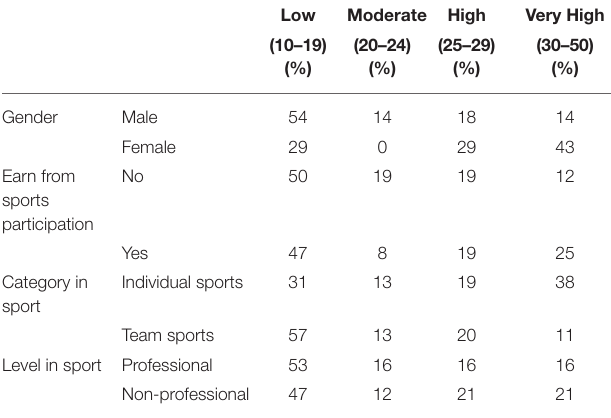
TABLE 2 | Prevalence of psychological distress by sample characteristics.